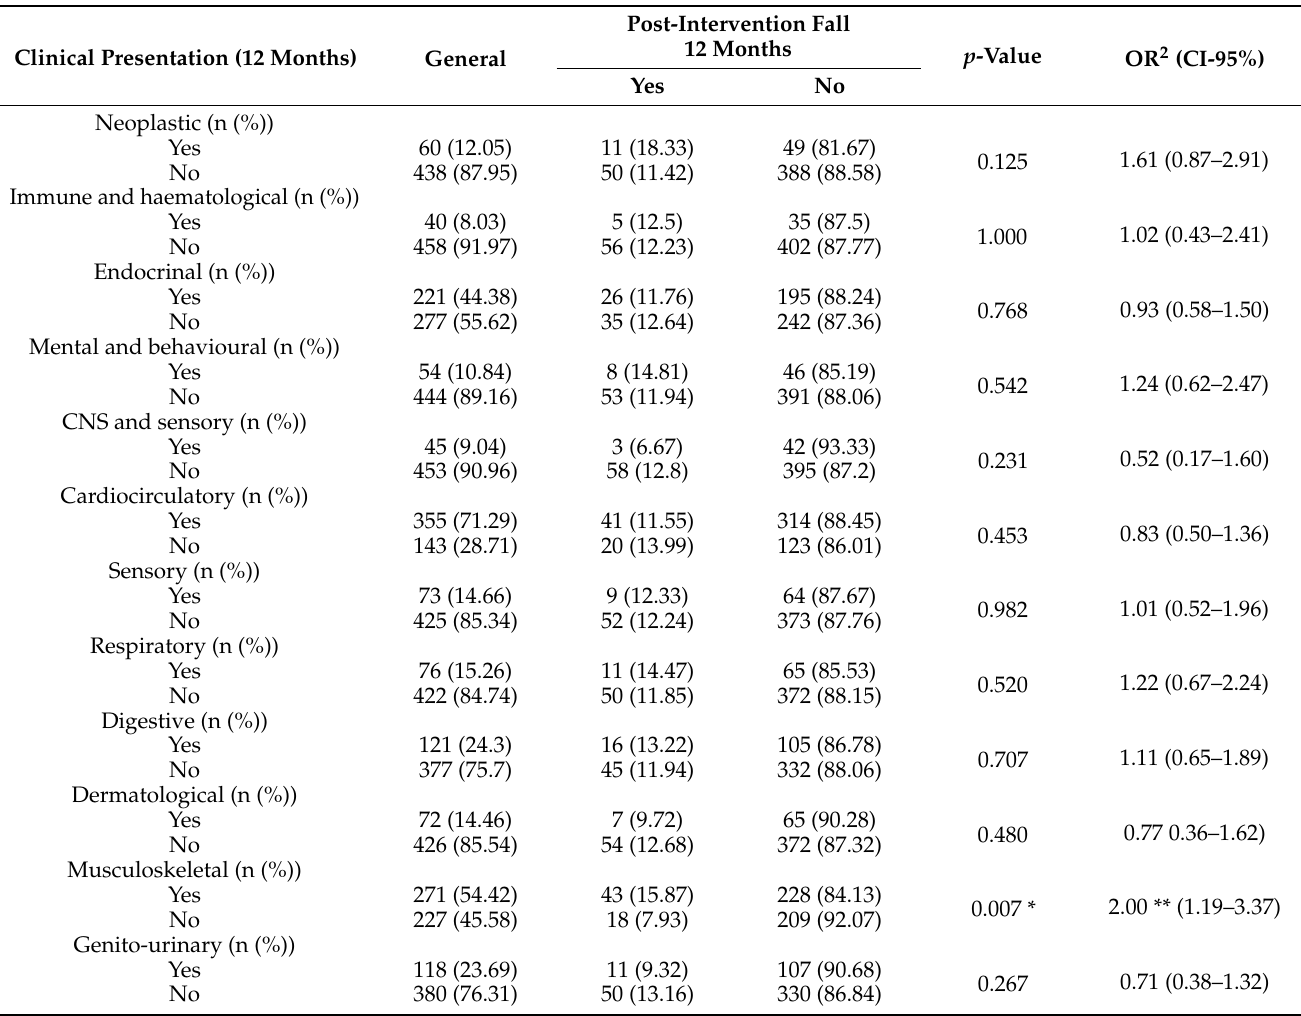
Table 6. Relationship between falls at 12 months and clinical presentation.